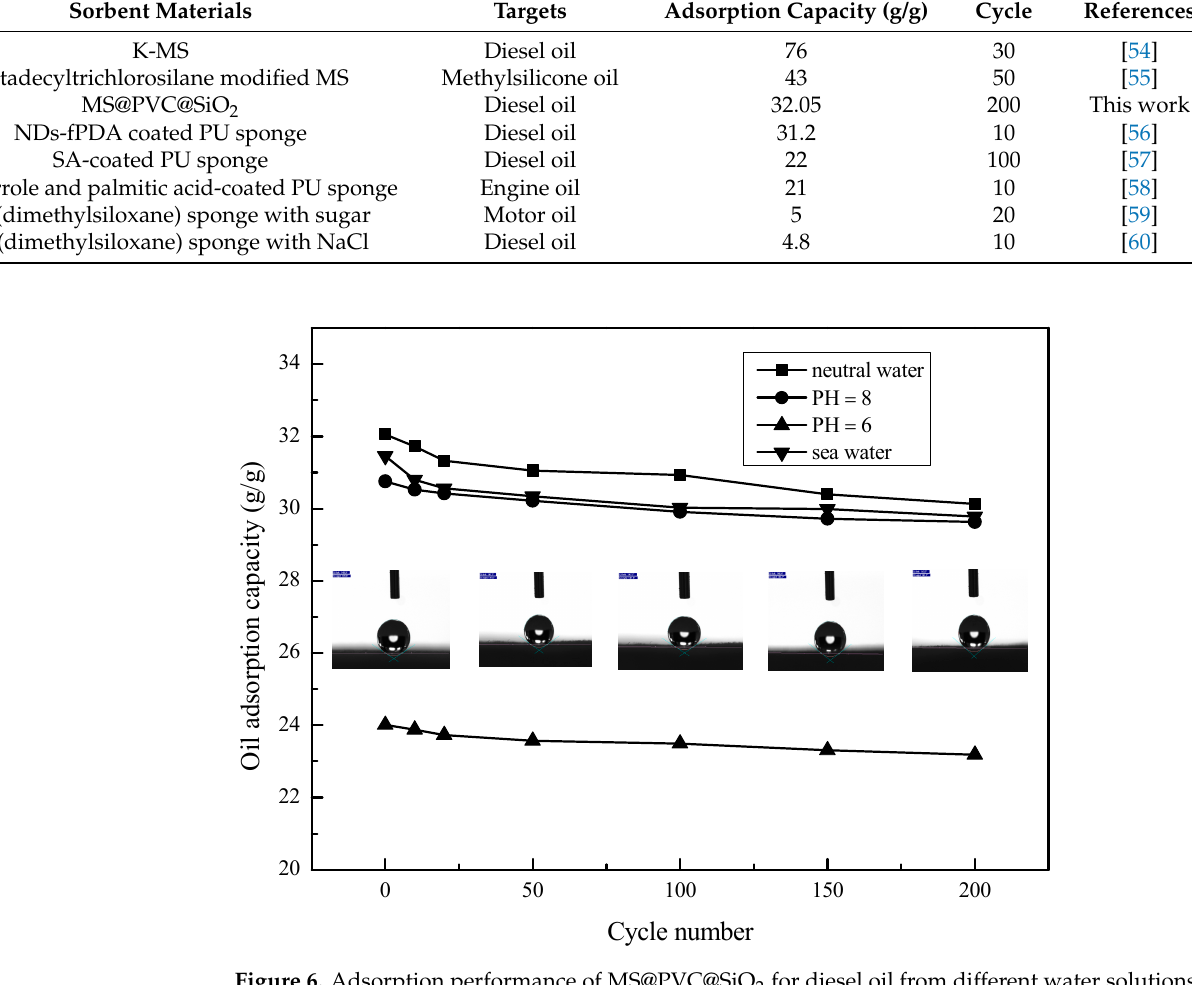
Figure 6. A dsorption performance of MS@PVC@SiO 2 for diesel oil from different water solutions. Figure 6. Adsorption performance of MS@PVC@SiO 2 for diesel oil from different water